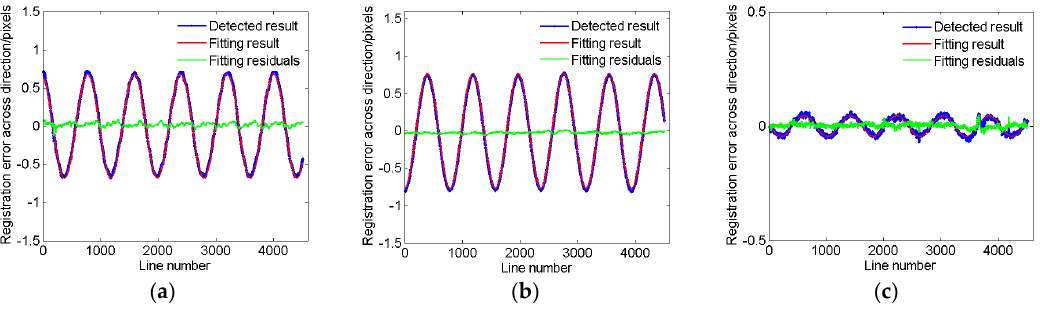
Figure 10. Parallax images between B1 and B2 along the track of ( a ) Scene A, ( b ) Scene B, and ( c ) Scene C.